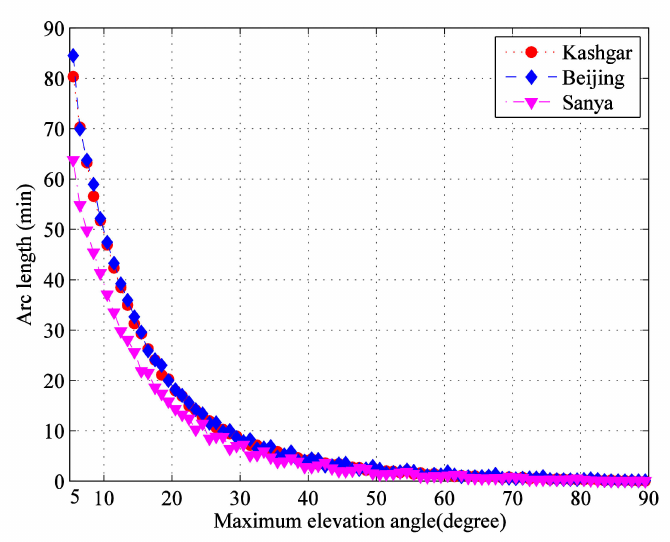
Figure 2. Transmission arc segment duration distributions of every 1 ◦ elevation angle.